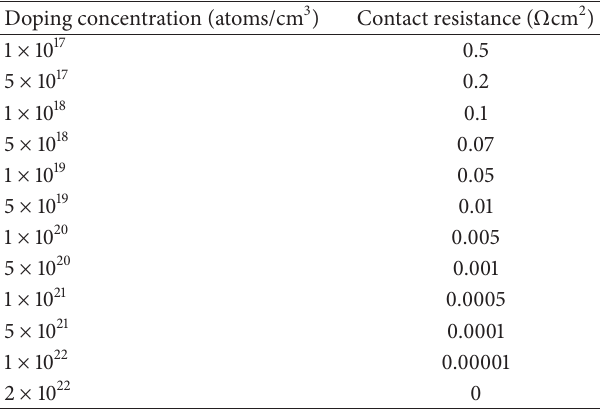
Table 1: Contact resistance at each doping concentration of boron. Doping concentration (atoms/cm 3 ) Contact resistance ( Ω cm 2